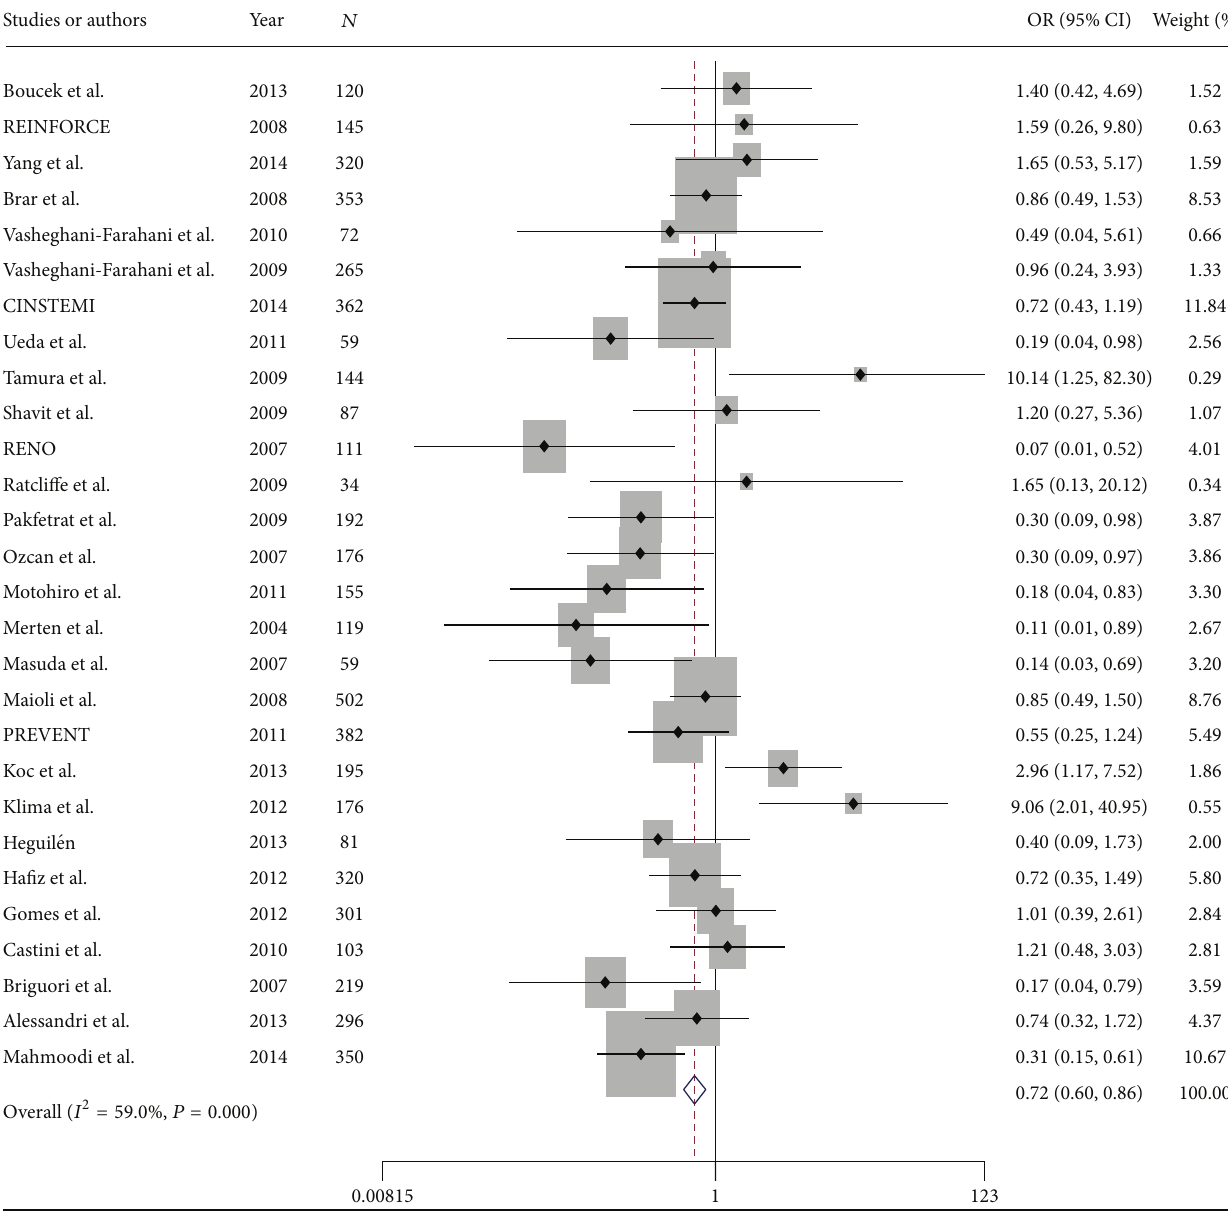
radiocontrast imaging compared to iso-osmolality and cases